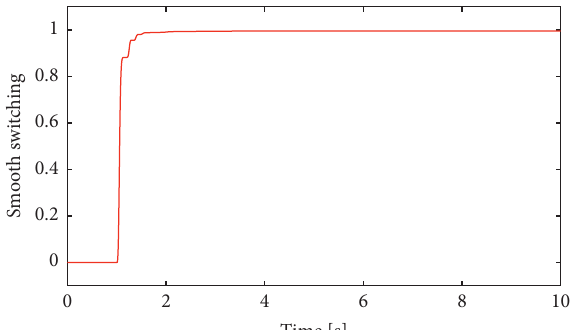
Figure 10: The smooth switching to take over between the controllers under bump wheel excitation.